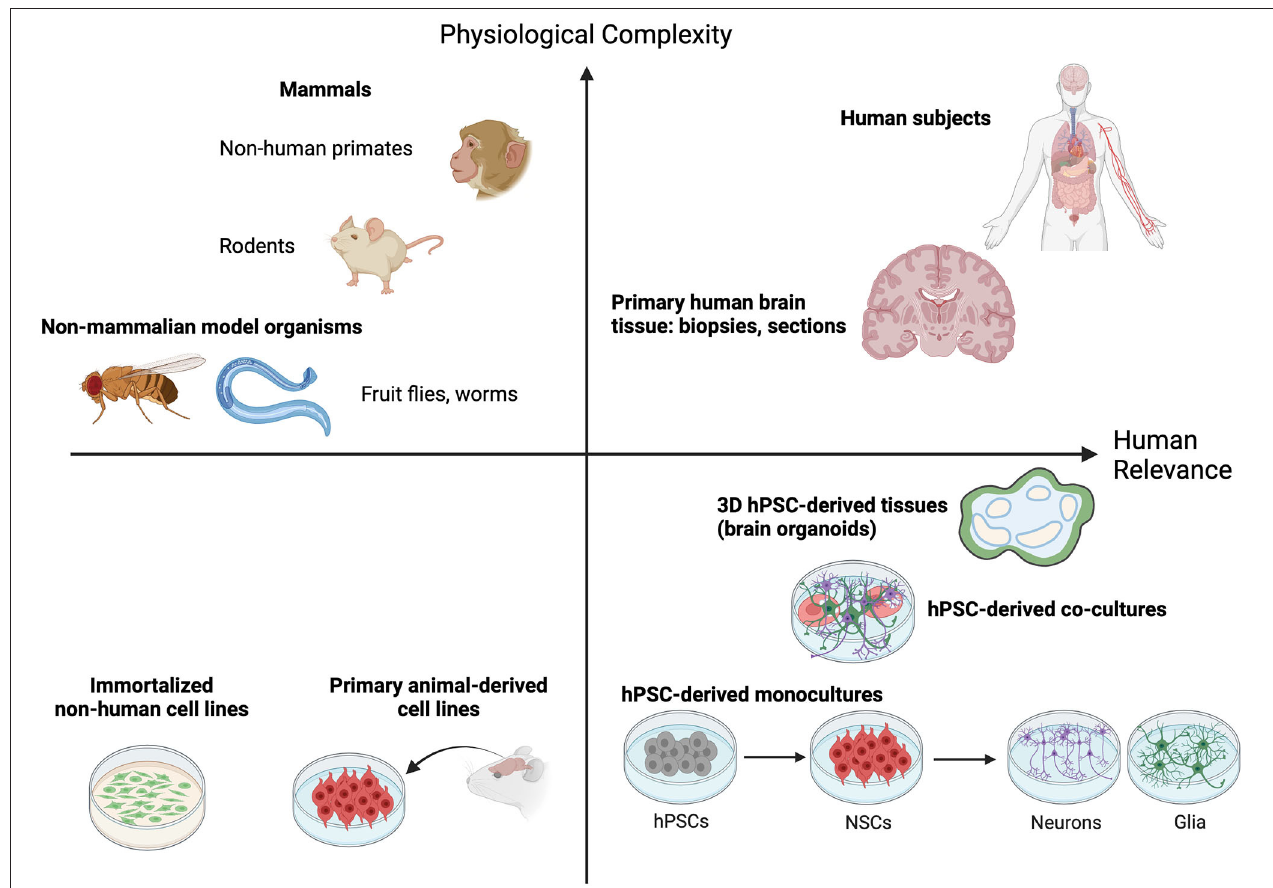
FIGURE 1 | Animal and cell culture models fall on a continuum that balances providing physiological complexity with human brain relevance. Non-mammalian model organisms like worms ( C. elegans ) and fruit flies ( D. melanogaster ) allow molecular and functional investigation of simple neuronal circuits and rational dissection of critical regulatory pathways in a physiologically relevant setting. Rodent and non-human primate models provide additional physiological complexity by permitting quantitative analysis of complex behavioral traits and simultaneously enrich relevance to the human condition. Human subjects and dissected human brain tissues fall high on both measures, but their procurement is rare or ethically impossible. The emergence of human pluripotent stem cell (hPSC)-derived 2D cell and 3D tissue models offer a highly needed source of neurological modeling tools with high relevance to the human brain. Though they offer less physiological complexity than animal models this capacity is ever increasing as technology advances (defined cell co-cultures and 3D tissue engineering). Furthermore, their relevance to the human condition is greatly enhanced compared to traditional culture of immortalized or non-human primary cell lines. A combination of hPSC-based and animal model approaches offers the best opportunity to capture both physiological complexity and relevance to the human